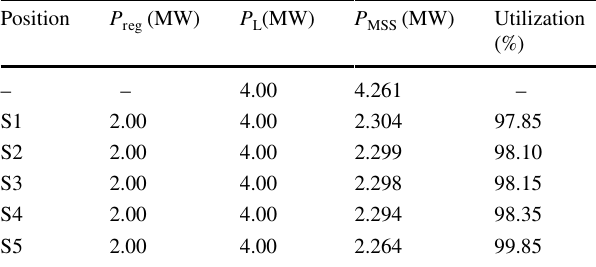
Table 5 Utilization rate of regenerative energy Position